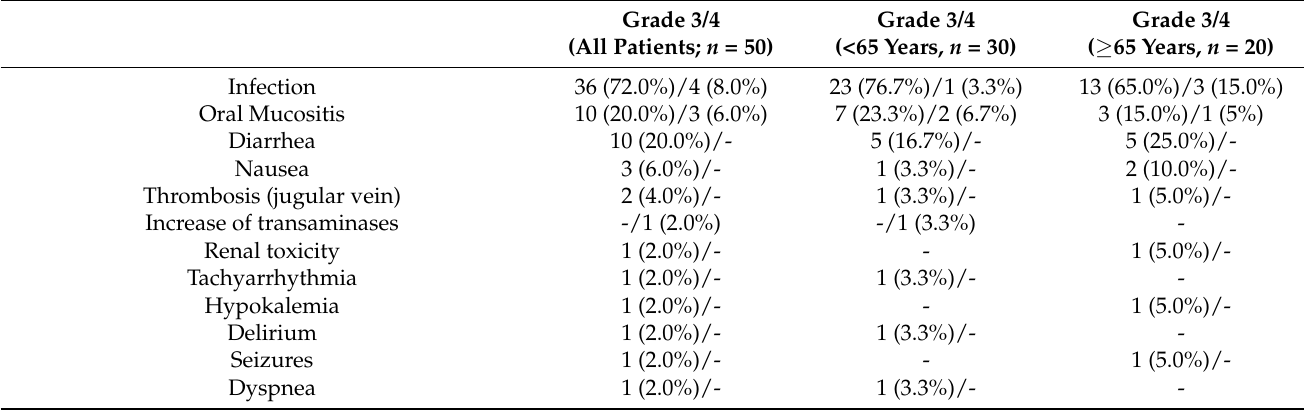
Table 3. CTC non-hematological Grade 3–4 toxicity in 50 patients who completed